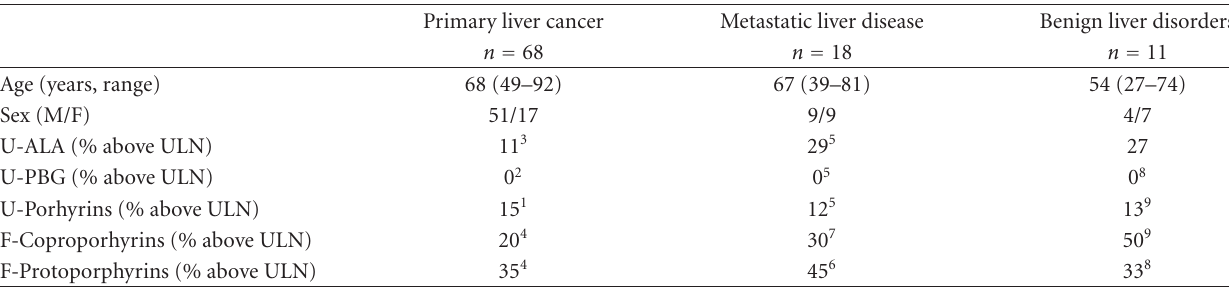
Table 1: Proportion of evaluable patients (%) with elevated urinary and/or faecal porphyrins measured as concentration of a metabolite above the laboratory reference range (Upper limit of normal, ULN) in cases with primary liver cancer, metastatic liver disease, and benign liver disorders. ALA : aminolevulinic acid; PBG : porphobilinogen.